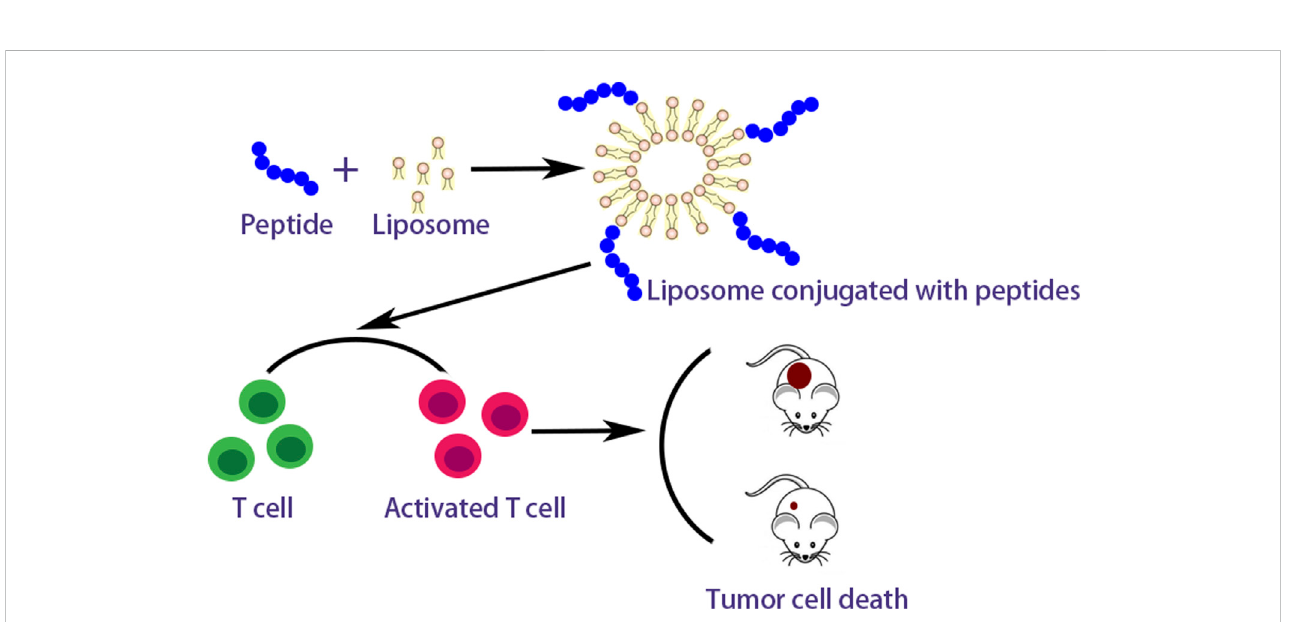
FIGURE 3 Action mechanism of peptide vaccines combined with